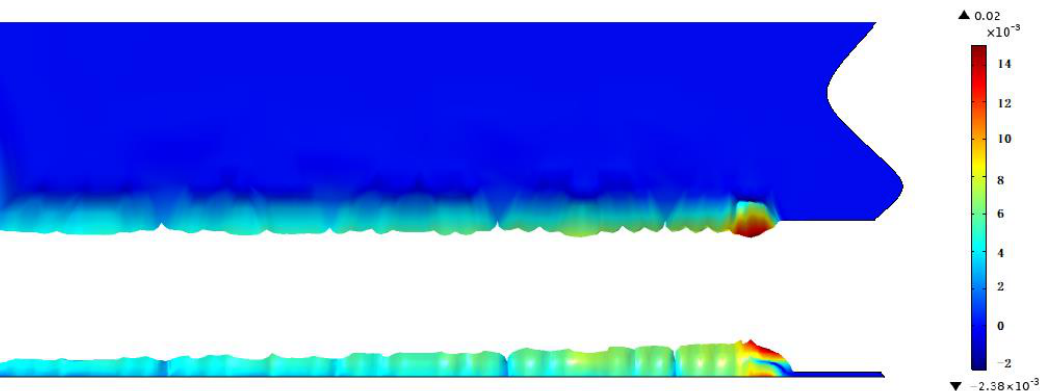
Figure 9. Thermal deformation of the slit when cutting for 1 s in working condition 2 (scale factor 1000).